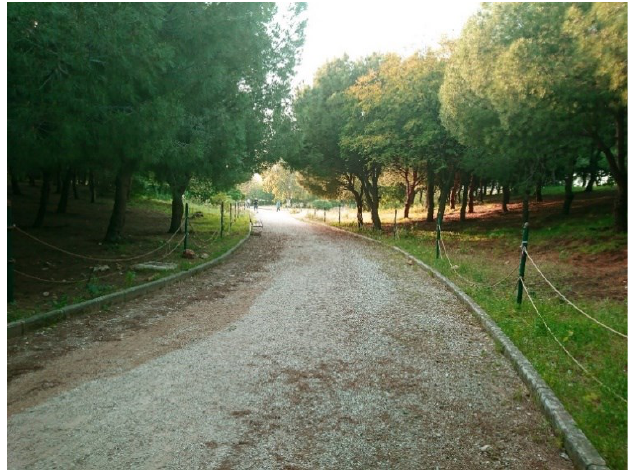
Figure 4. The Horsh Beirut Park, between Badaro, Qasqas, and Barbir areas, Beirut (adapted from Maria A. El Helou photo